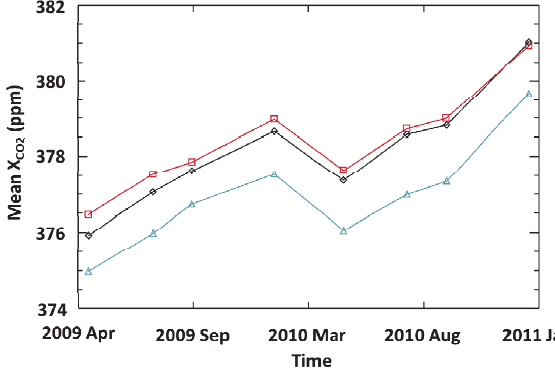
Fig. 3. Mean X CO estimates over Australia are shown as a function Figure 3. Mean X CO2 estimates over Australia are shown as a function of time for three 2 2 different estimates of the time-dependent throughput of the TANSO-FTS. The blue curve 3 of time for three different estimates of the time-dependent through- shows X CO2 retrievals assuming that the radiometric calibration coefficients derived from 4 put of the TANSO-FTS. The blue curve shows X CO pre-launch tests did not change. A preliminary version of the time-dependent throughput 5 suming that the radiometric calibration coefficients derived from correction was included in the B2.8 product (black line). A refined, time-dependent 6 pre-launch tests did not change. A preliminary version of the time- throughput correction that was developed more recently (red curve), produces an additional 7 dependent throughput correction was included in the B2.8 product X CO2 correction that decreases from ~0.5 ppm early in the GOSAT mission to slightly less 8 (black line). A refined, time-dependent throughput correction that than zero in early 2011. 9 was developed more recently (red curve), produces an additional X CO correction that decreases from ∼ 0.5ppm early in the GOSAT 2 mission to slightly less than zero in early